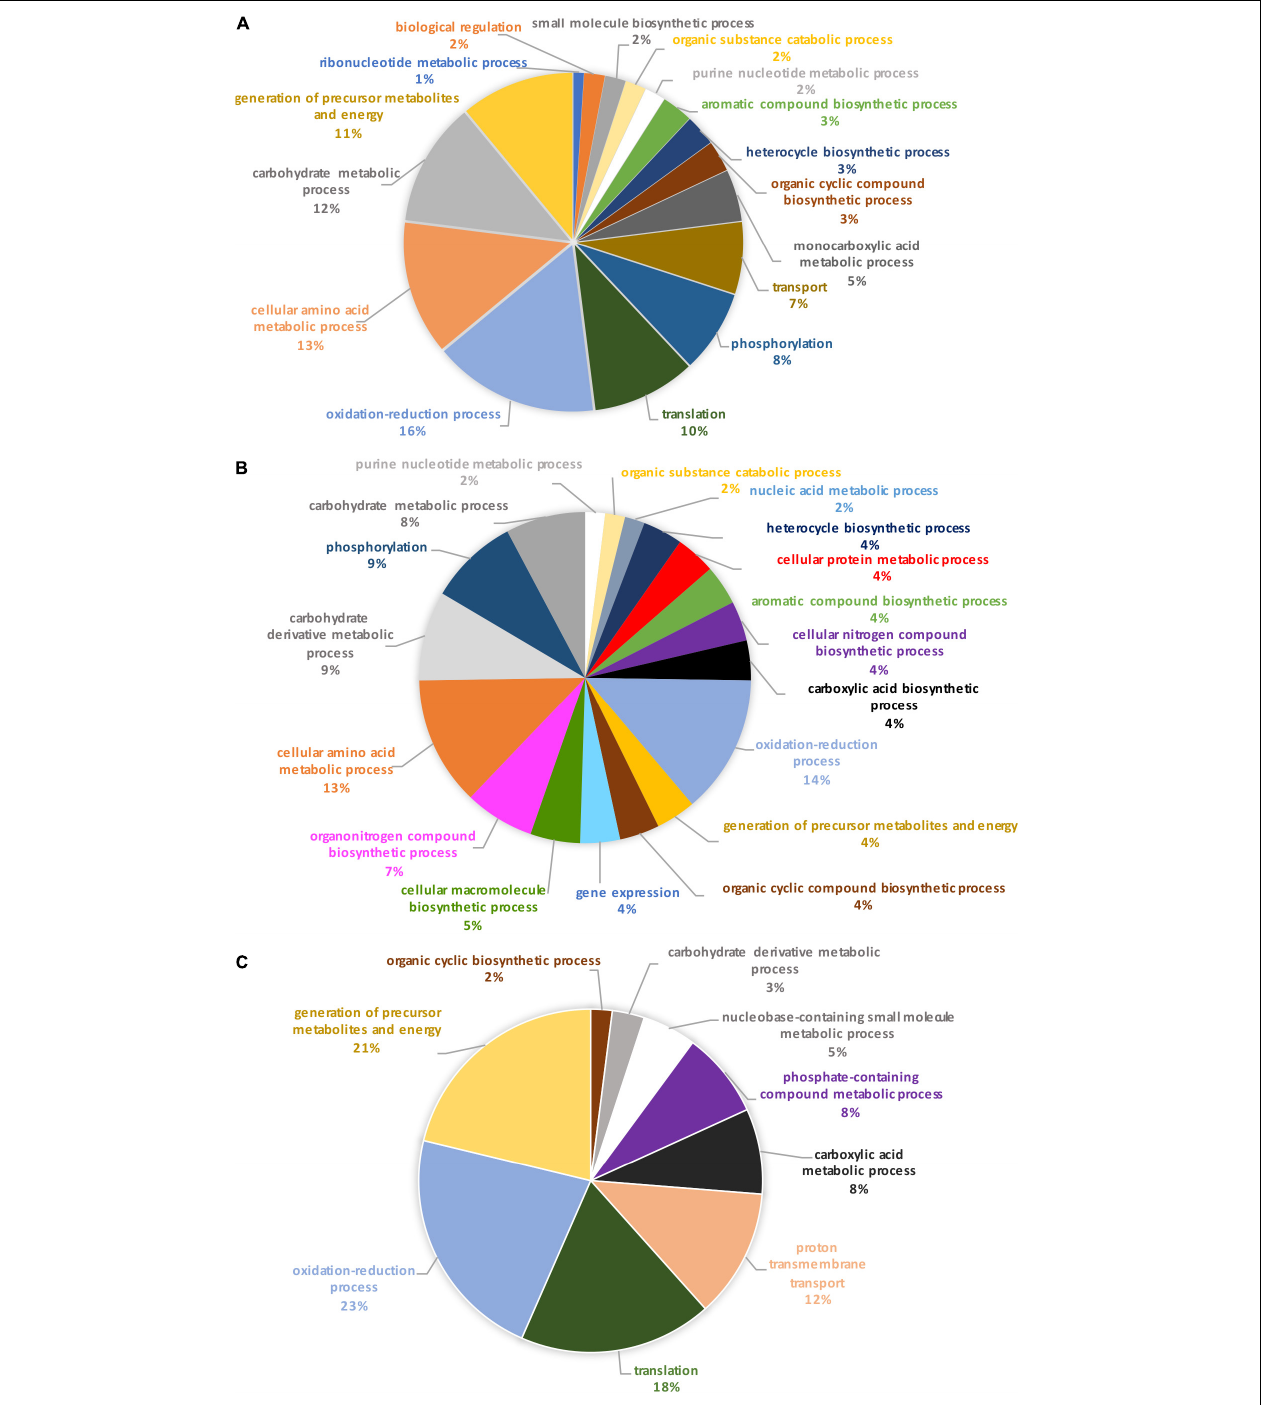
FIGURE 3 | Pie charts representing the biological processes, which are alliterated in the OF pairwise comparison. (A) Overall biological processes associated with the overall differentially expressed proteins in the oval morphotype when compared to the fusiform one. (B) Biological processes which are associated with the up-regulated proteins. (C) Biological processes associated with down-regulated